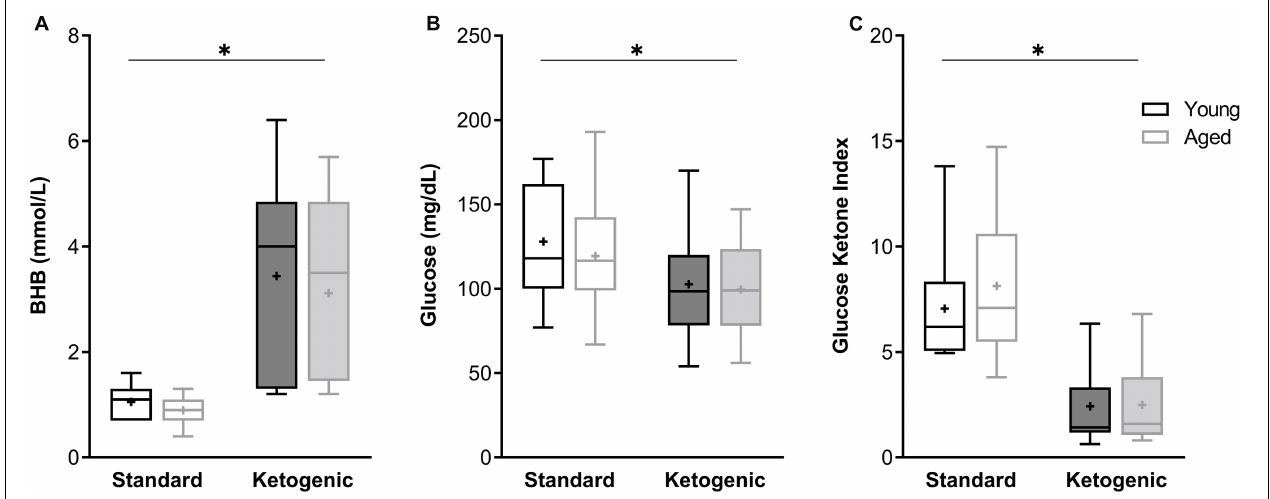
FIGURE 1 | The ketogenic diet-fed rats had significantly higher (A) BHB, lower (B) glucose and lower (C) GKI relative to standard diet-fed rats, regardless of age group. Boxes represent the upper and lower quartiles around the median, the whiskers are the minimum and maximum observed values and + indicates the group mean. ∗ = main effect of